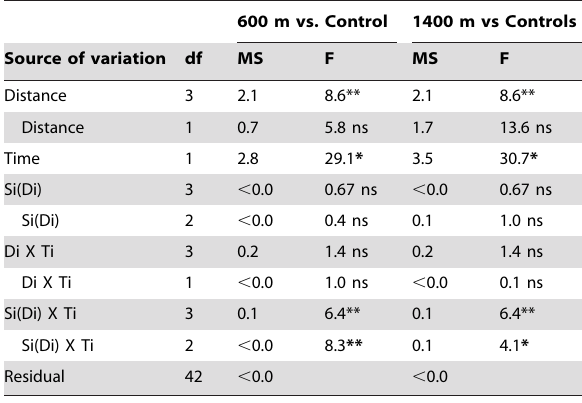
Table 4. Univariate analyses of variance of the percentage cover of biofilm on panels submerged in different sites in all sampling times.